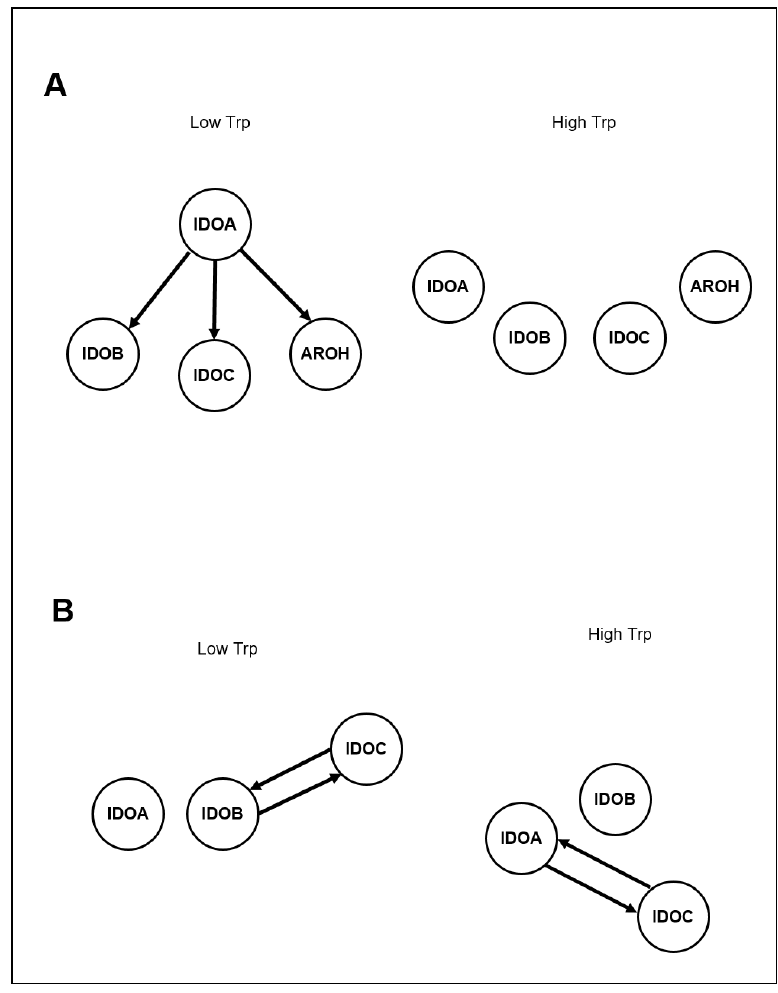
Figure 3. Networks of predicted regulatory interactions learned from RT-PCR time-course data for wild-type strain (Panel A ), and aroH deletion (Panel B ) experimental conditions. In both cases, separate networks were inferred by using data from low-Trp (off) and high-Trp (on) experiments, for a total of four separate networks.